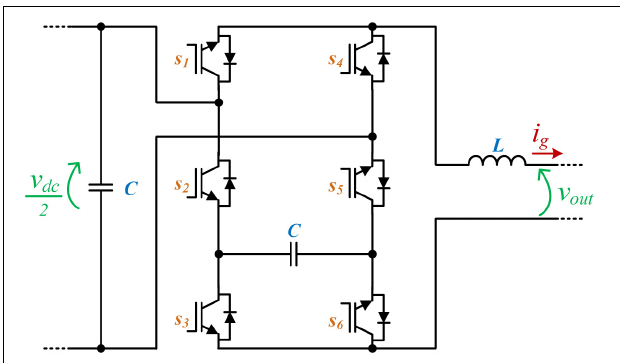
FIGURE 4 | Topology proposed in Vahedi et al.